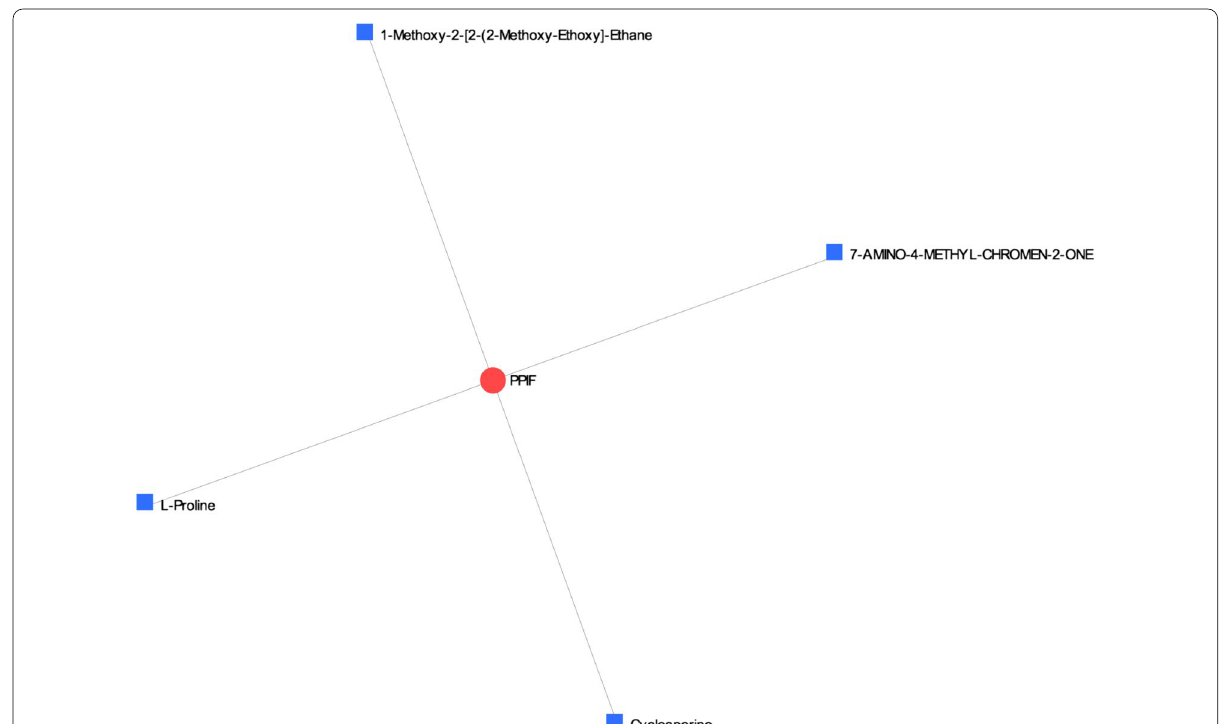
Fig. 6 Gene-drug network analysis for identified significant DEGs. The identified DEGs are illustrated by circles and associated chemicals are presented by